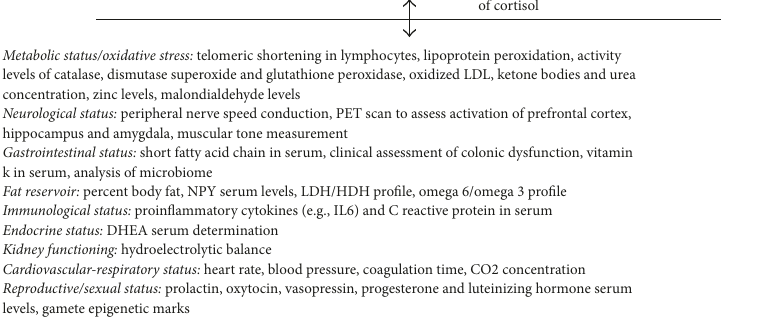
Figure 2: Models to assess stress. (a) An integrated model of stress. This layered model depicts the levels of organization, organic systems, and factors that might interact with one another within a multidimensional framework to sustain stress responses. In this context, if a handful of the elements depicted are acutely challenged (e.g., thirst stress response), the organism will only require a homeostatic response while keeping the set points of the parameters involved in such a response relatively unchanging. In contrast, if most body systems are acutely, subacutely, or chronically challenged (e.g., normal pregnancy), the organism would be forced to develop an allostatic response. This circumstance would provoke shifts in the set points of the parameters involved in such a response. Finally, if the entire body is acutely, subacutely, or chronically challenged(e.g.,truegestationalstress),theorganismwouldbeforcedtomountapantostaticstressresponsefallingintoastateofderegulation and disease. (b) Protocol to evaluate stress in the pregnant woman. This layered model of diagnosis, backed up by the model of stress, described above, aims to protocolize the psychological, clinical, and biochemical tests that must be used to effectively diagnose stress during pregnancy, assuming this as an allostatic challenge to the mother embedded into the multidimensional framework that sustains